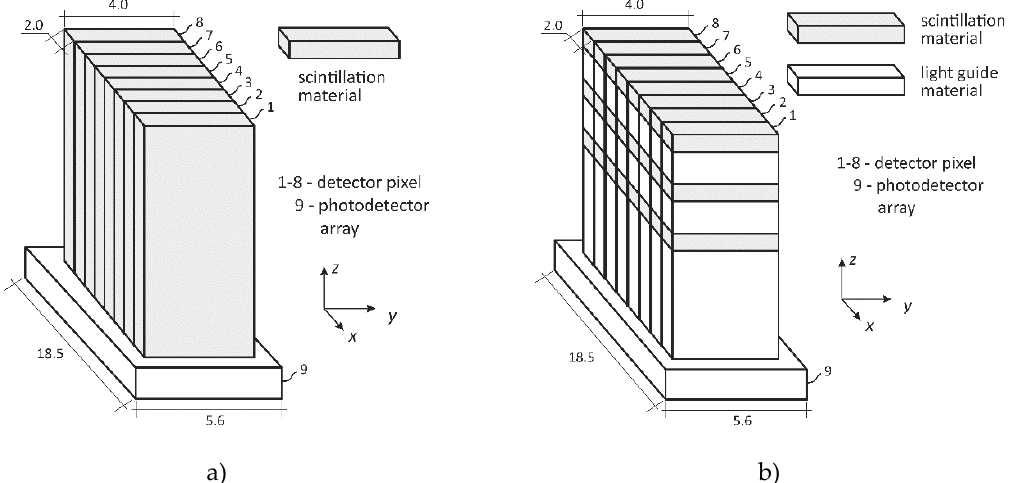
Figure 5. Design of a scintillation ( a ) bar and ( b ) sandwich multi-plane detector (MPD) module with eight detector channels that are seamlessly arranged and coupled to a line array of avalanche photodiodes.